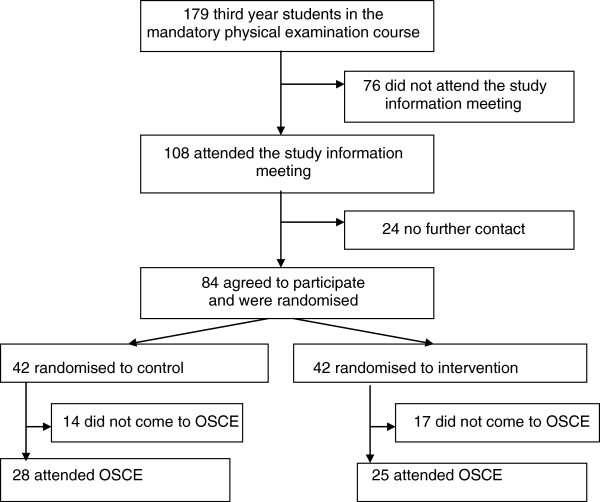
Trial flow chart.